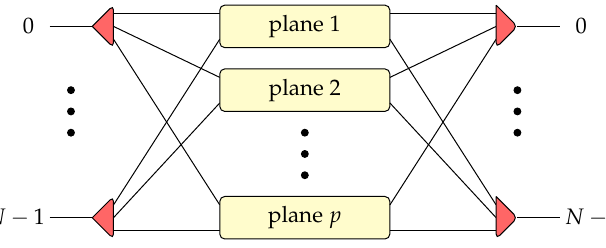
Figure 2. The idea of a multiplane switching fabric. N − 1 switching fabric The exact number of planes p used to build the multi-log 2 or the baseline switching fabric depends strongly on the type of nonblocking conditions, i.e., the strict-sense nonblocking (SSNB), the wide-sense nonblocking (WSNB), and the rearrangeable nonblocking (RRNB) conditions. The SSNB and the RRNB conditions for N − 1 switching fabric were described in detail and proved the space-division multi-log 2 N − 1 switching network was later extended to the modified baseline in [16]. The multi-log 2 architecture (MBA) switching fabric, whereas the SSNB and RRNB conditions for this switching network were delivered in [12] and [18], respectively. In a more general case, such a network is called the MBA ( N , e , 2 ) switching fabric. The N is the capacity of this switching network, e is the maximal number of inputs or outputs one switching element can have, and two means it is possible to extend this switching fabric to a structure of two-times greater capacity (number of inputs/outputs). For details about the MBA ( N , e , 2 ) switching fabric see